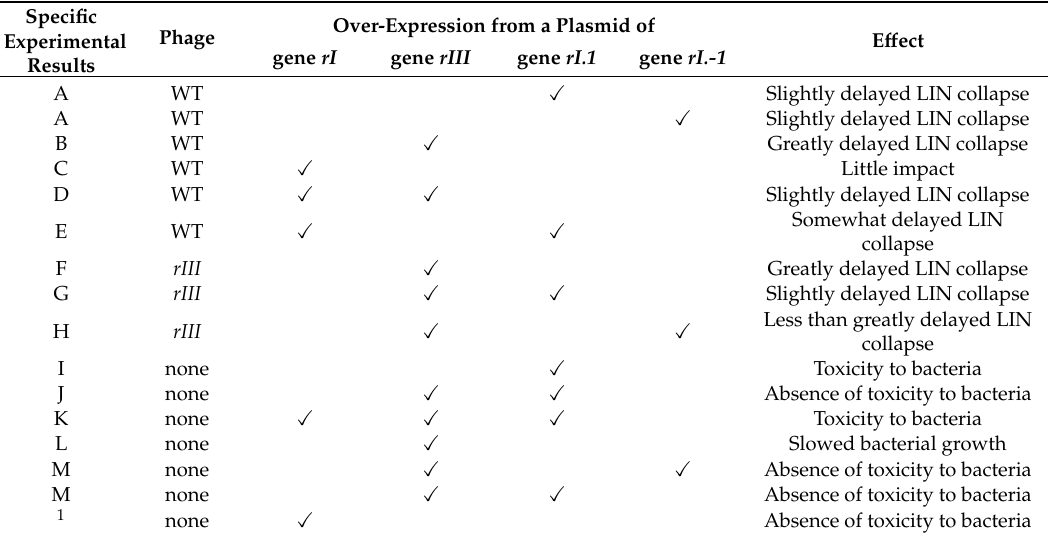
Table 3. Summary of Golec et al. [96]